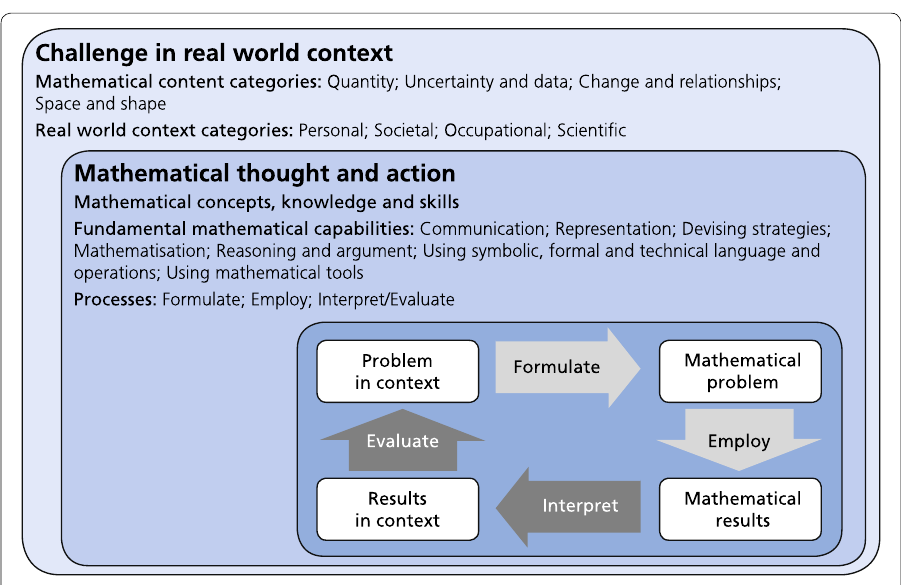
Fig. 2 A model of mathematical literacy in practice (OECD 2013, p.